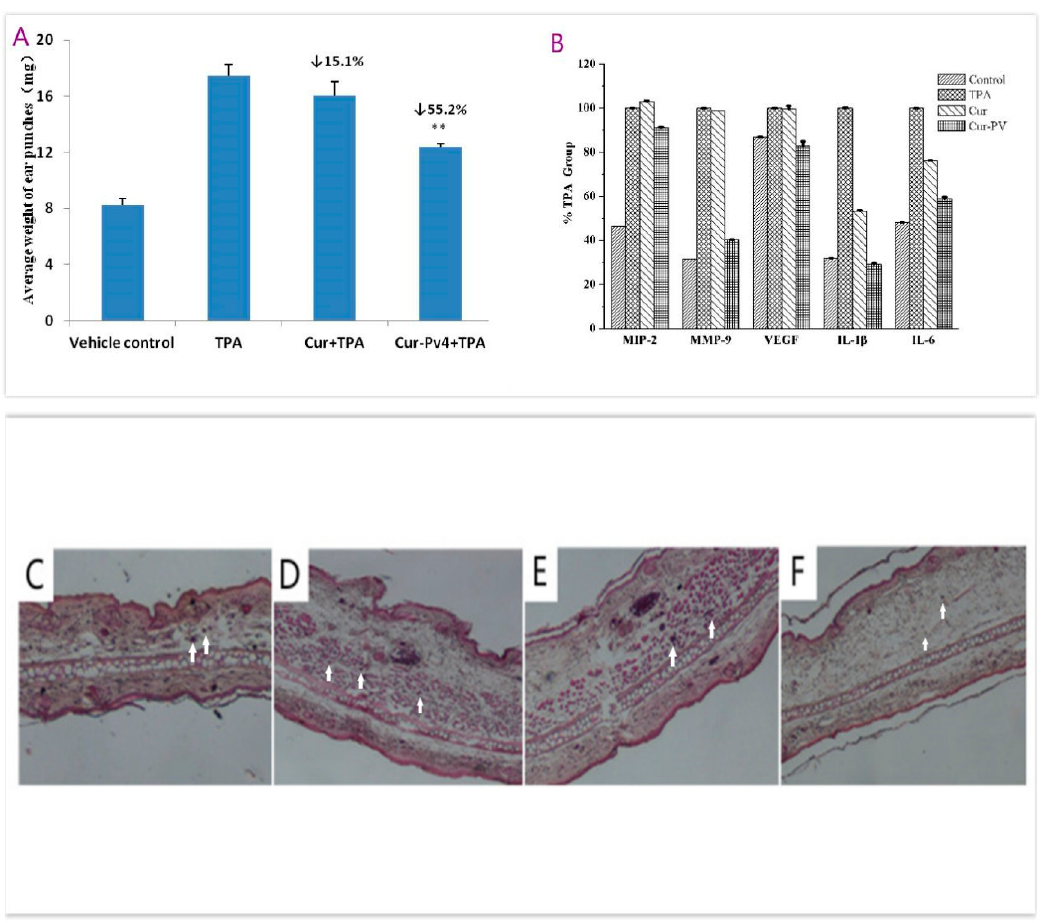
Figure 14. ( A ) Effect of Curcumin and Cur-PV4 on the weight of ear punches, with ( B ) immunohistochemical staining on IL-1 β , IL-6, MMP-9, MIP-2, and VEGF and H&E staining for histological changes of TPA-induced mouse ears: ( C ) Acetone, ( D ) TPA, ( E ) Curcumin, and ( F ) Cur- PV4. Magnification 200 × (3). Each value represents the mean ± S.D. ( n = 3).